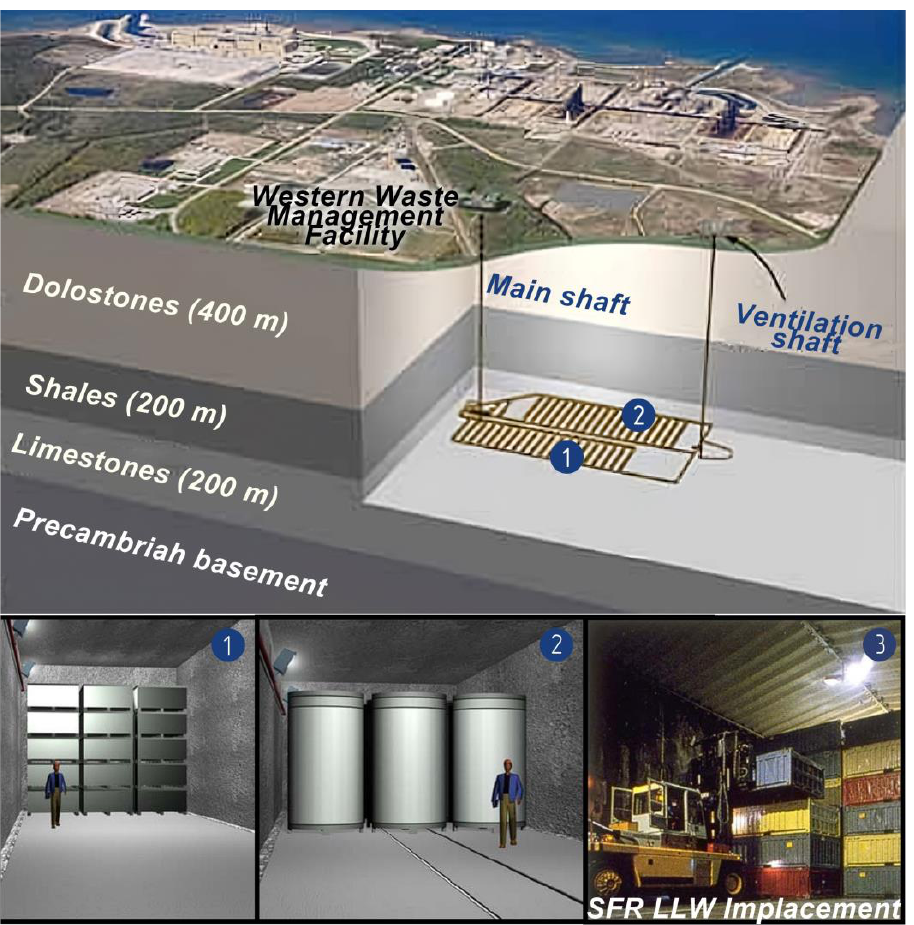
Figure 6. Proposed concept of placing LLW and ILW in the Bruce site repository and illustration of disposal cells with ( 1 ) low-, ( 2 ) intermediate-level waste and ( 3 ) operations to place radioactive waste in SFR repository (Sweden), much like those in the planned Canadian one [43,44]. It is planned to strengthen the floor of the radioactive waste cells with concrete, and after filling it with concrete wall without backfilling and sealing [43]. Access shafts to the cells will be isolated with concrete caps and low-permeable materials, in particular a mix- ture of bentonite and sand [43].